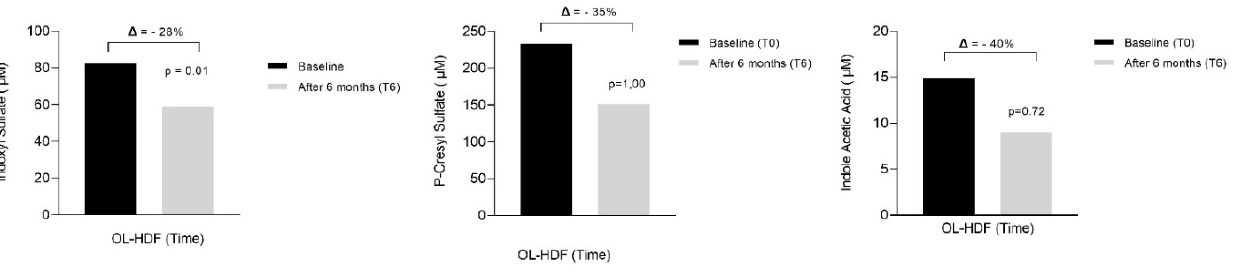
Figure 1. Percentual change in serum concentration of uremic toxins after 6 months of online hemodiafiltration (OL-HDF).